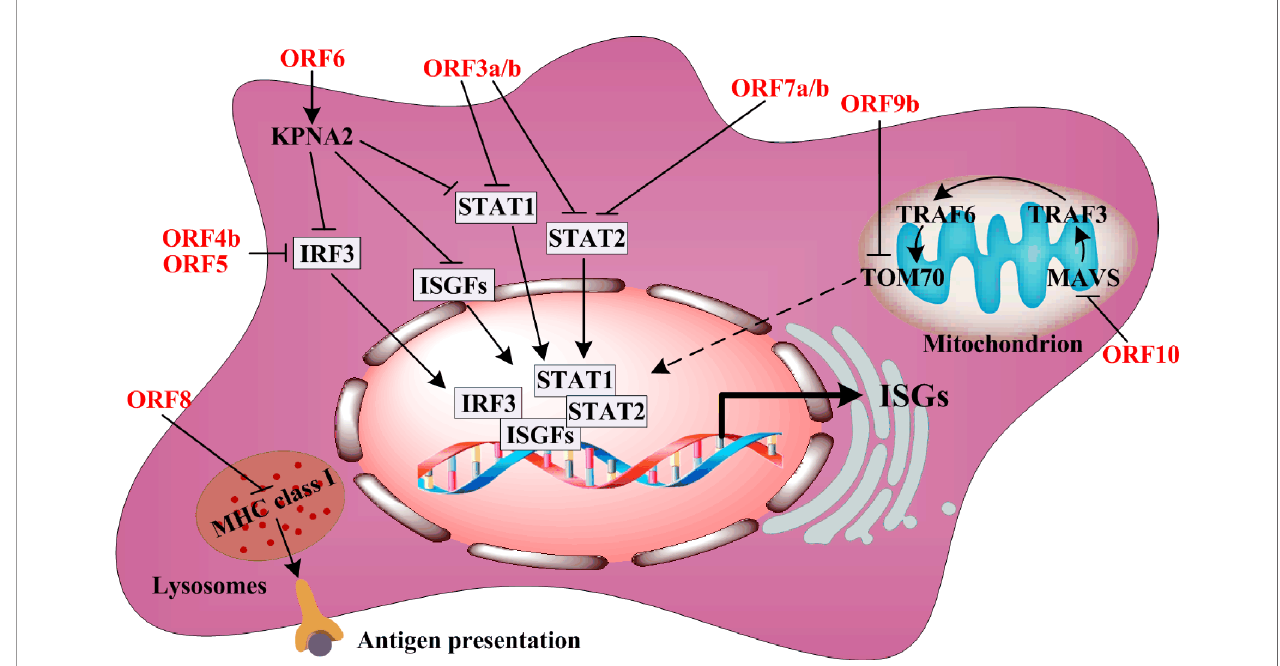
FIGURE 3 | The regulation of ORFs on body